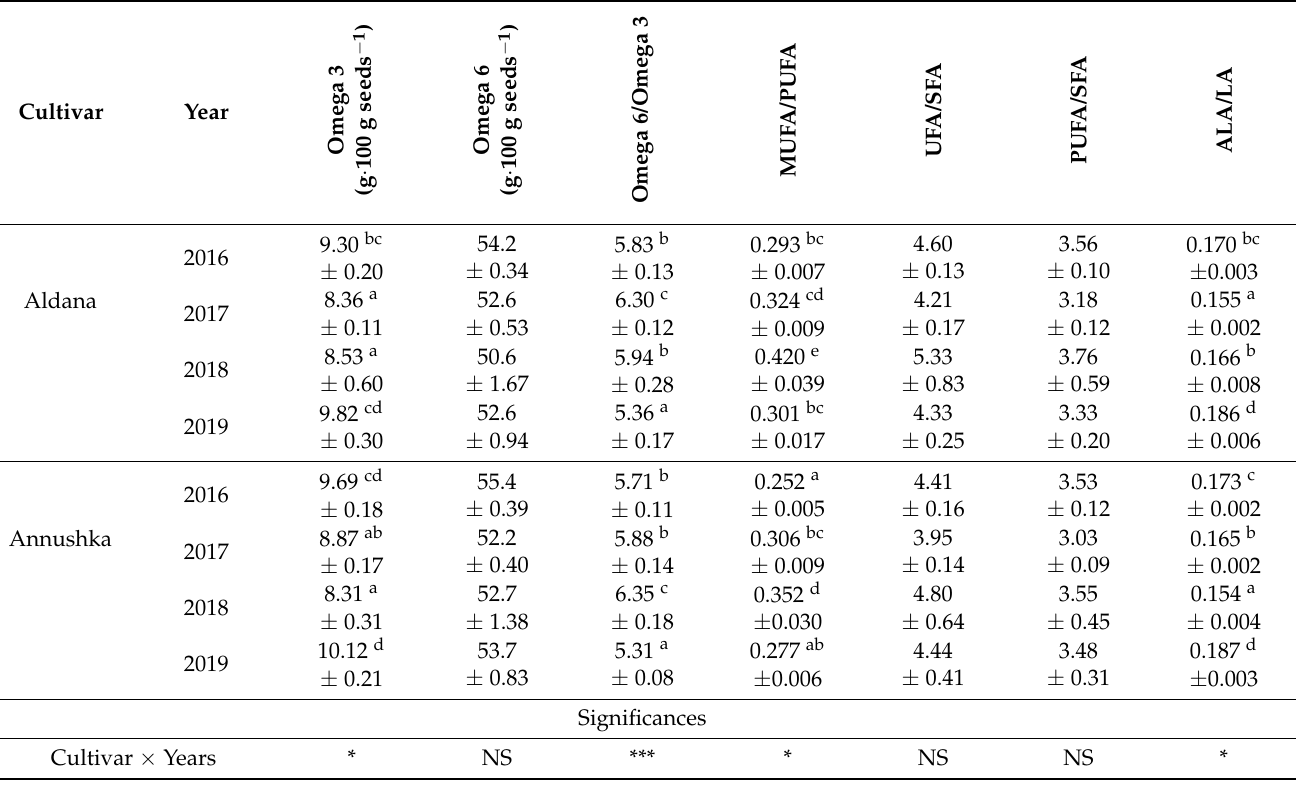
Table 4. The content of Omega 3 and Omega 6 (g FA 100 g seeds − 1 ) as well as the ratio of Omega 6/Omega 3, MUFA/PUFA, PUFA/SFA, UFA/SFA and ALA/LA in G. max seeds; mean values for interaction cultivar ×